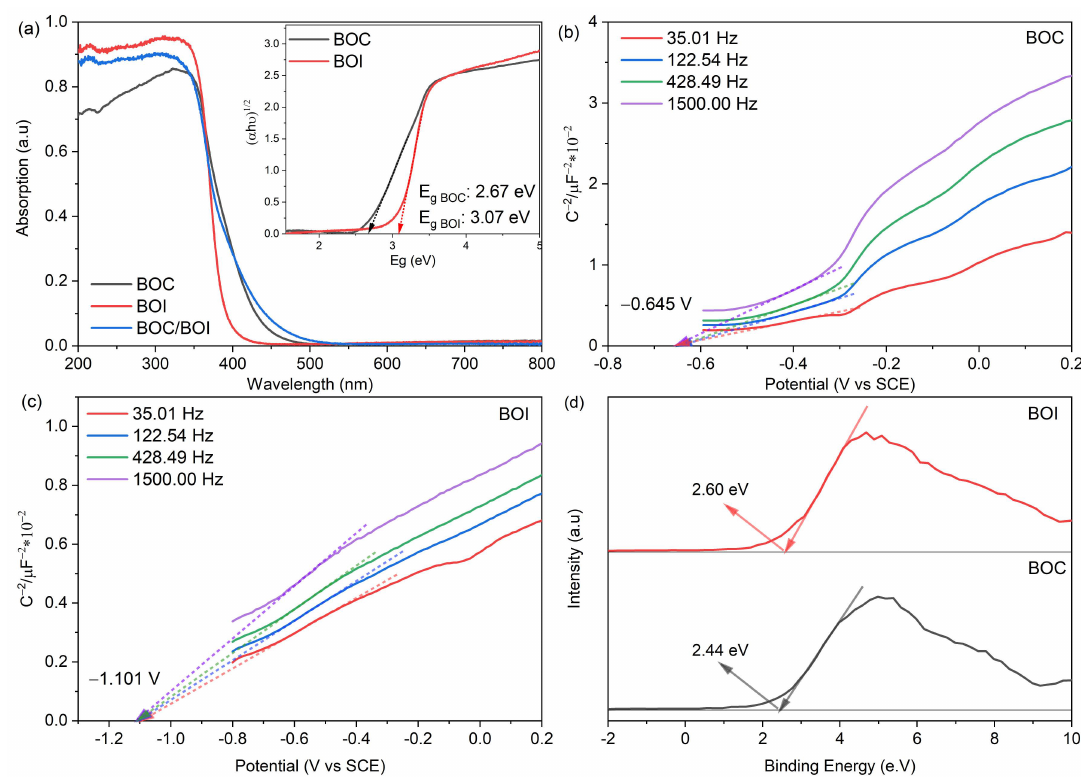
Figure 10. ( a ) UV–Vis diffuse reflectance spectra of BOC, BOI and BOC/BOI-3, (inset) showing Tauc plot of BOC and BOI, ( b , c ) Mott–Schottky plot of BOC and BOI, ( d ) Valence band XPS of BOC and